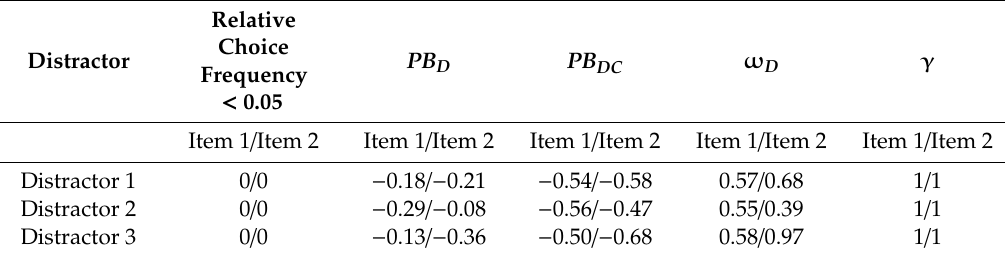
Table 1. Distractor specific statistics for Example-item 1 and Example-item